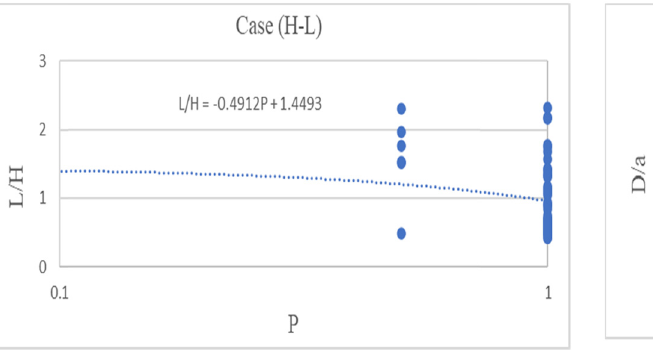
Figure 11: The relation of rootstocks length to upstream water head ( L / H ) to trap index ( p ) for cases ( H – L ) .